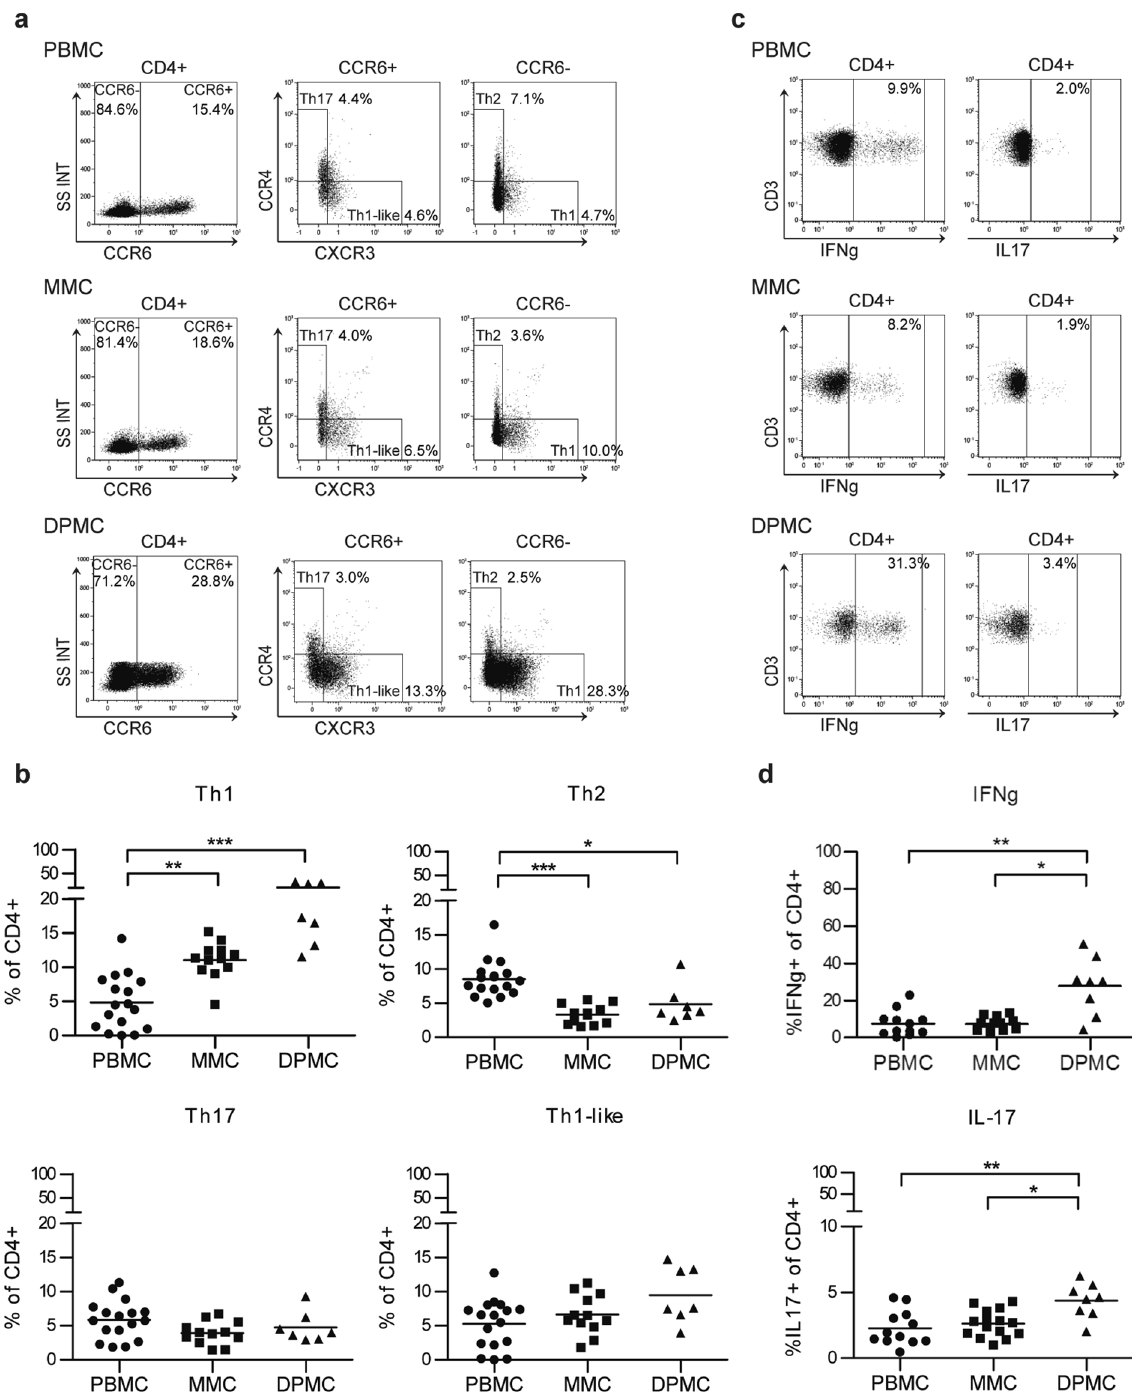
Figure 4. Distribution of CD4 + Th cell subsets in peripheral blood (PBMC), menstrual blood (MMC), and term decidua parietalis (DPMC) and production of IFN- γ and IL-17 by CD4 + T cells. ( a , c ) Representative gating for CCR6, CXCR3, and CCR4 on CD4 + T cells and for IFN- γ and IL-17 by CD4 + T cells from PBMC, MMC, and DPMC. ( b ) Th1, Th2, Th17, and nonconventional Th1 (Th1-like) CD4 + T cells can be classified based on the expression of CCR6, CXCR3, and CCR4 34 . CCR6 − CXCR3 + CCR4 − , Th1; CCR6 + CXCR3 + CCR4 − , Th1-like; CCR6 − CXCR3 − CCR4 + , Th2; CCR6 + CXCR3 − CCR4 + , Th17 (PBMC n = 17, MMC n = 11, DPMC n = 7). ( d ) Production of IFN- γ and IL-17 by CD4 + T cells from PBMC (n = 12), MMC (n = 15), and DPMC (n = 7). * P < 0.05, ** P < 0.01, and *** P < 0.001 (lines indicate mean, non-parametric Kruskal-Wallis with Dunns post-hoc